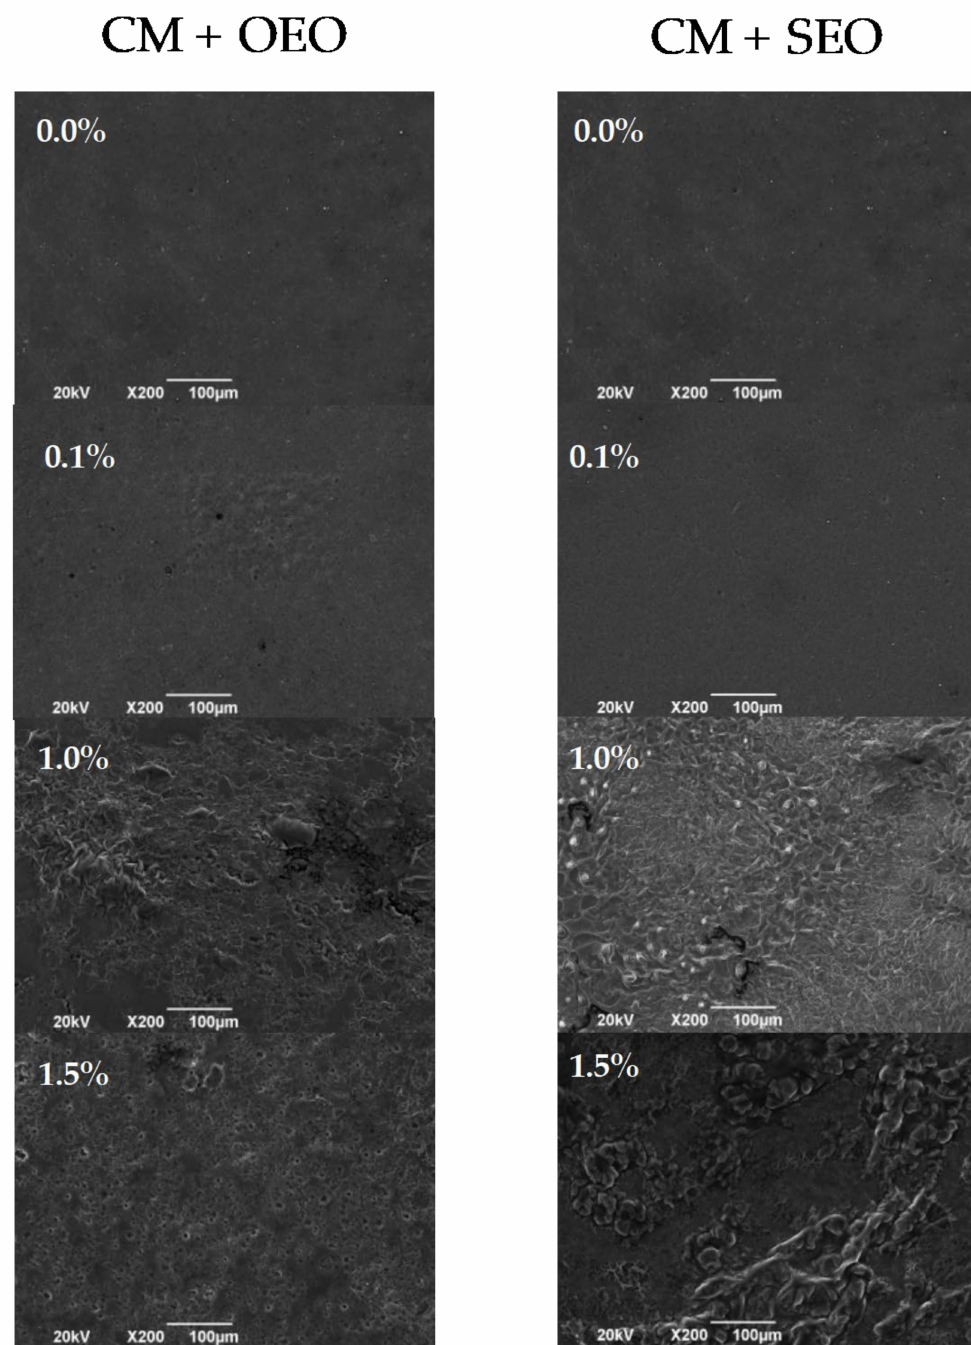
Figure 3. SEM micrographs of the film’s surface with different concentrations of oregano (OEO)